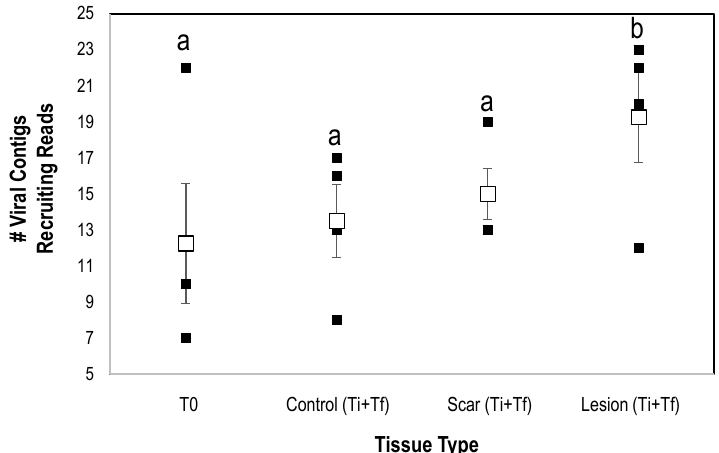
Figure 9. Richness of viral genome fragments recruiting reads from SSWD-affected and grossly normal tissues in viral metagenomes prepared from P. ochraceus during temporal study of wasting. Significance (a,b) determined by Student’s t -test ( p < 0.008, df = 4 with Bonferroni correction for 6 tests). T0 = initial sample, Ti = time of first lesion appearance, Tf = experiment termination. Open squares represent mean (error bars = SE).